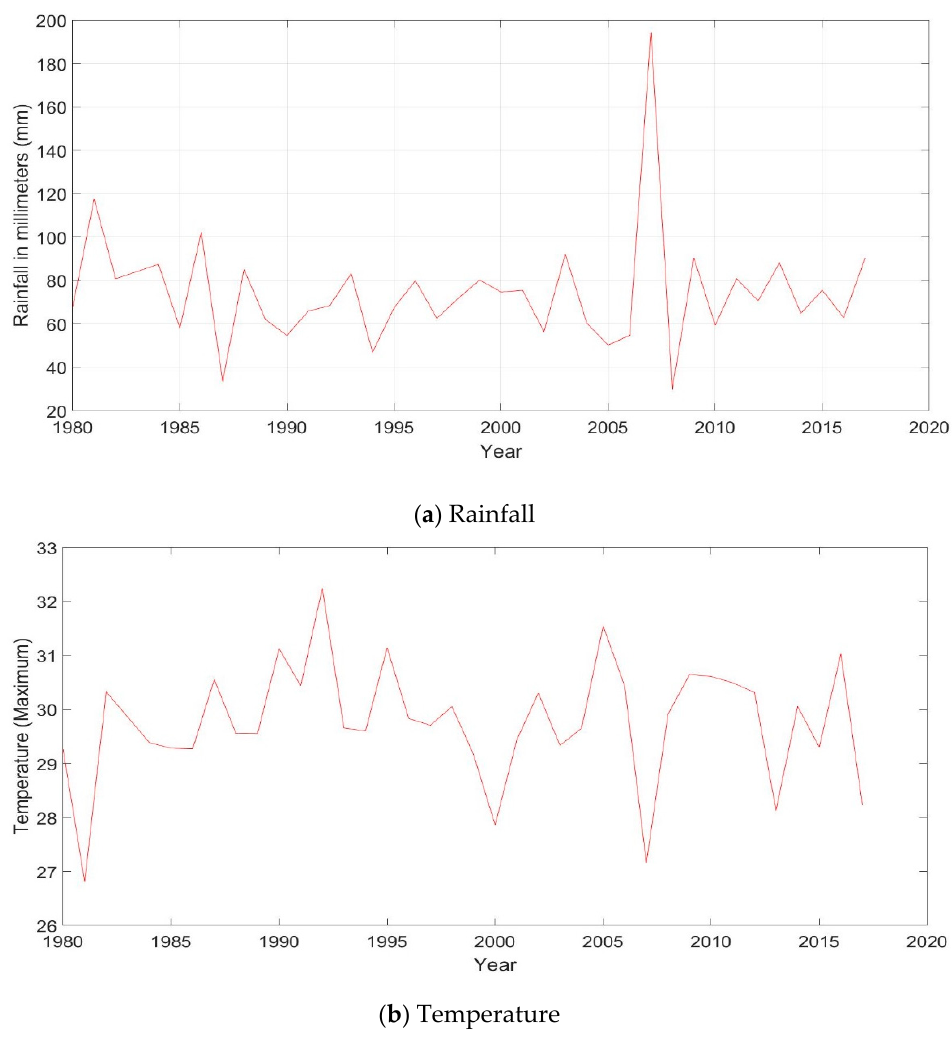
Figure 1. Climate variability in Chiredzi District from 1980 to 2017, ( a ) rainfall and ( b ) maximum temperature.